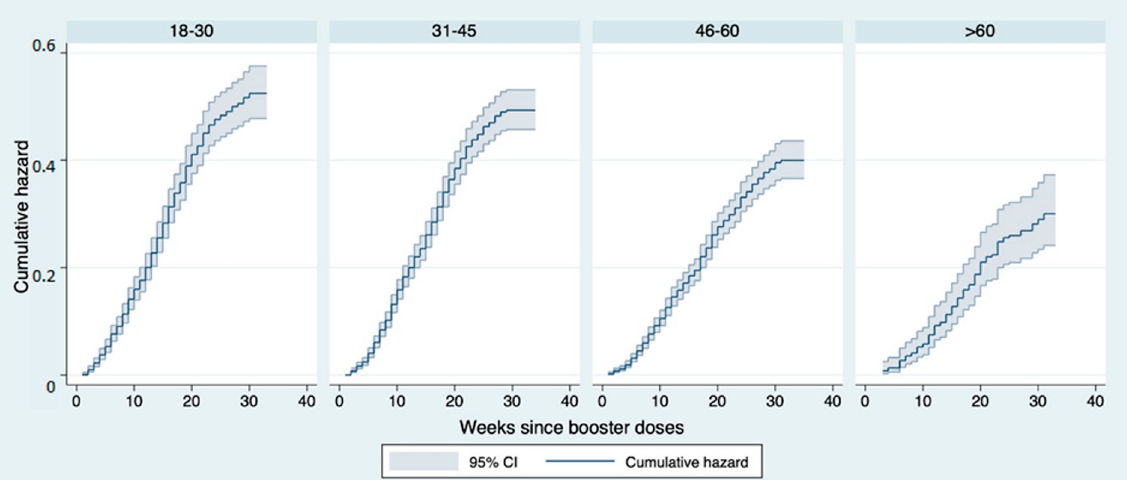
Figure 4. Nelson–Aalen cumulative hazard estimates: curves representing the cumulative risk of infection after booster dose stratified by age group in the follow-up period.